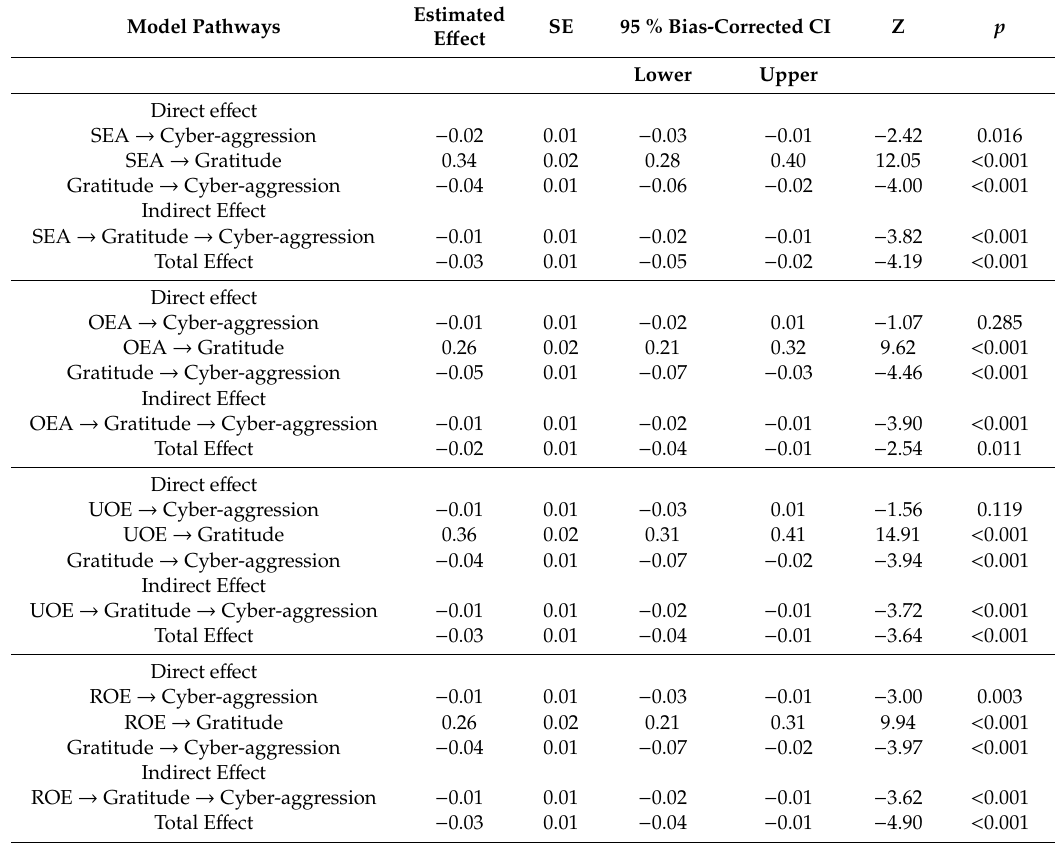
Table 2. The test of indirect e ff ect in model of EI and cyber-aggression mediated by gratitude. Estimated SE 95 % Bias-Corrected CI Z p Model Pathways E ff ect Lower Upper Direct e ff ect SEA → Cyber-aggression − 0.02 0.01 − 0.03 − 0.01 − 2.42 0.016 SEA → Gratitude 0.34 0.02 0.28 0.40 12.05 < 0.001 − 0.04 0.01